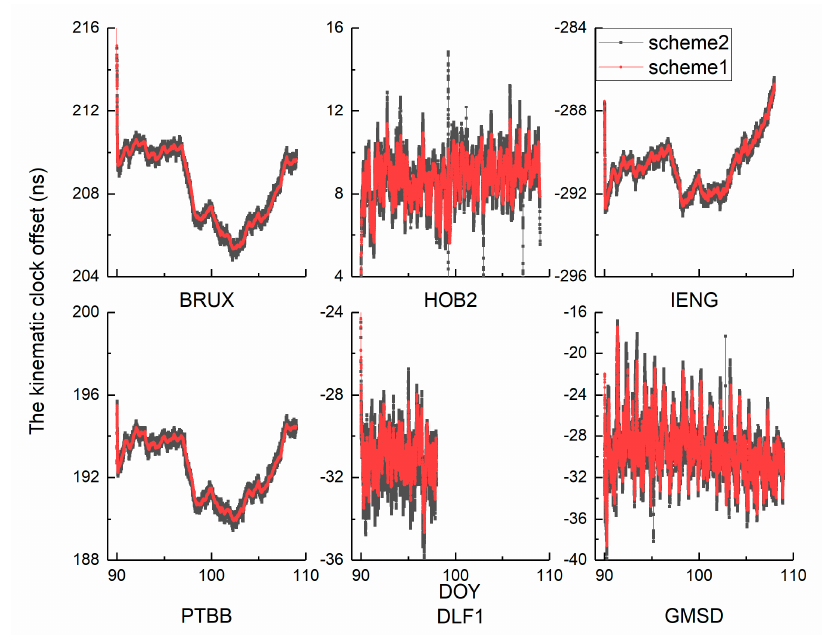
Figure 9. The kinematic clock offset time series of GPS PPP.